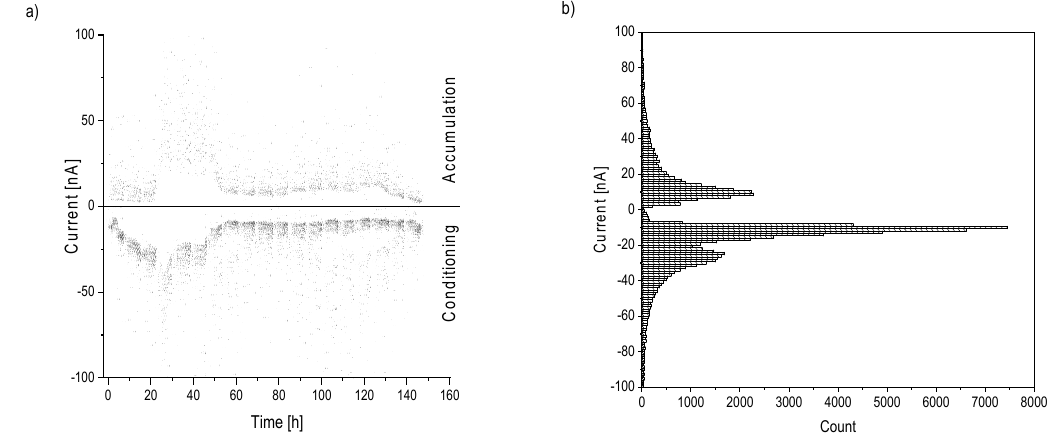
Figure 7. ( a ) Accumulation ( I acc > 0) and conditioning current ( I cond < 0) for six days of continuous CSV to measure microbial sulfide emission. AWW 2 at room temperature with E cond = − 0.9 V, t cond = 5 s, E acc = − 0.1 V vs. Ag / AgCl and t acc = 2 s. Every 30 min, four consecutive cycles were performed and 10 data points per second were recorded. ( b ) Histogram of accumulation and condition current to illustrate the distribution of data points of time series in ( a ).